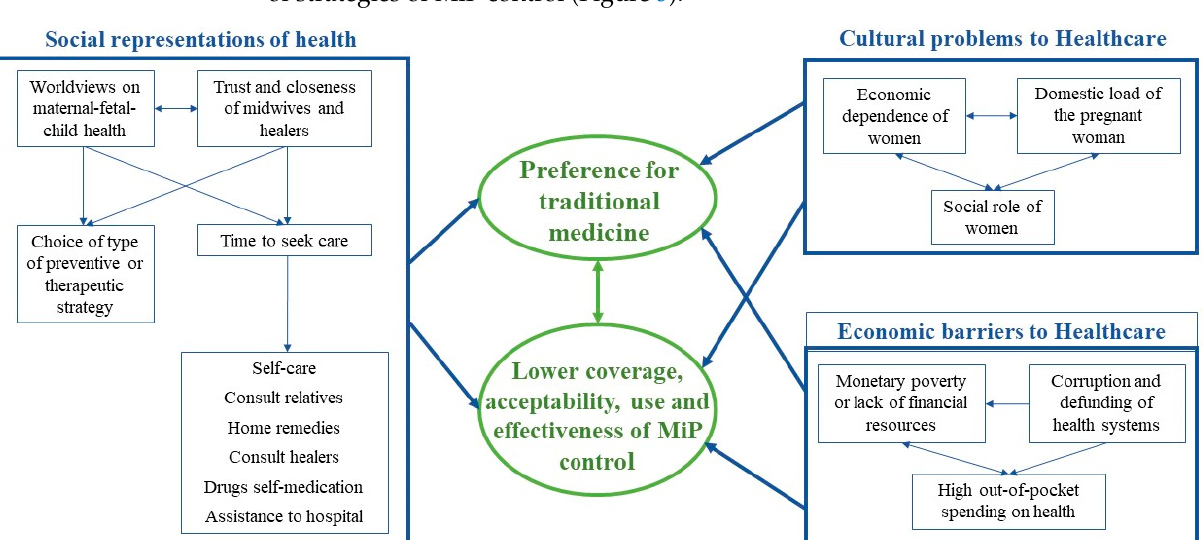
Figure 5. New category relationships to understand determinants of MiP control.